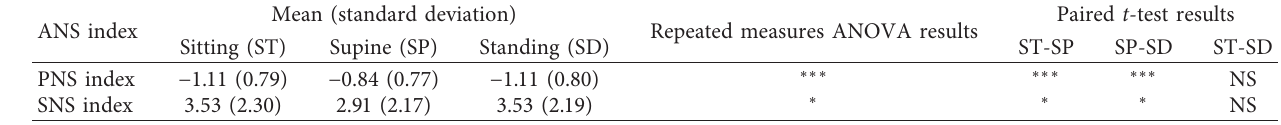
Table 2: Descriptive statistics, repeated measures ANOVA, and paired t -test for ANS indices.